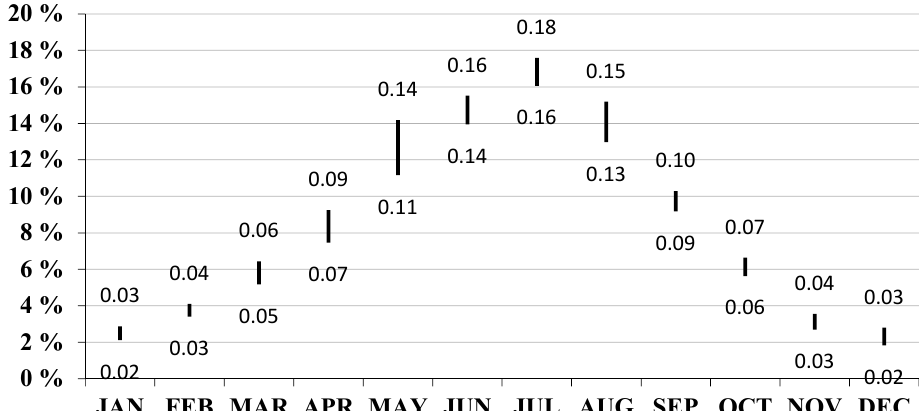
Figure 3. Probability distribution of evapotranspiration, with extreme values.